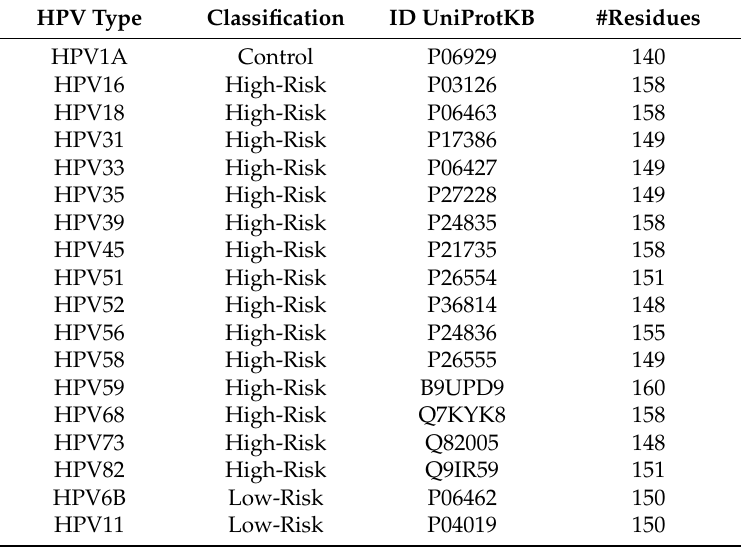
Table 2. Primary sequences of high and low-risk HPV E6